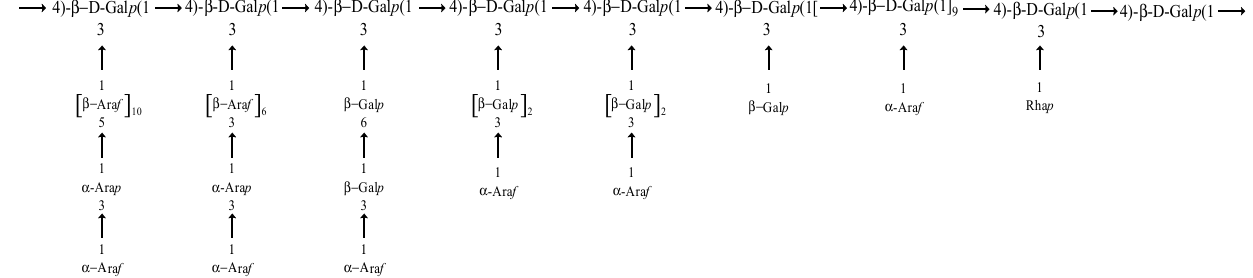
Figure 11. One of possible structure of the repeat unit of LbGp4-OL.